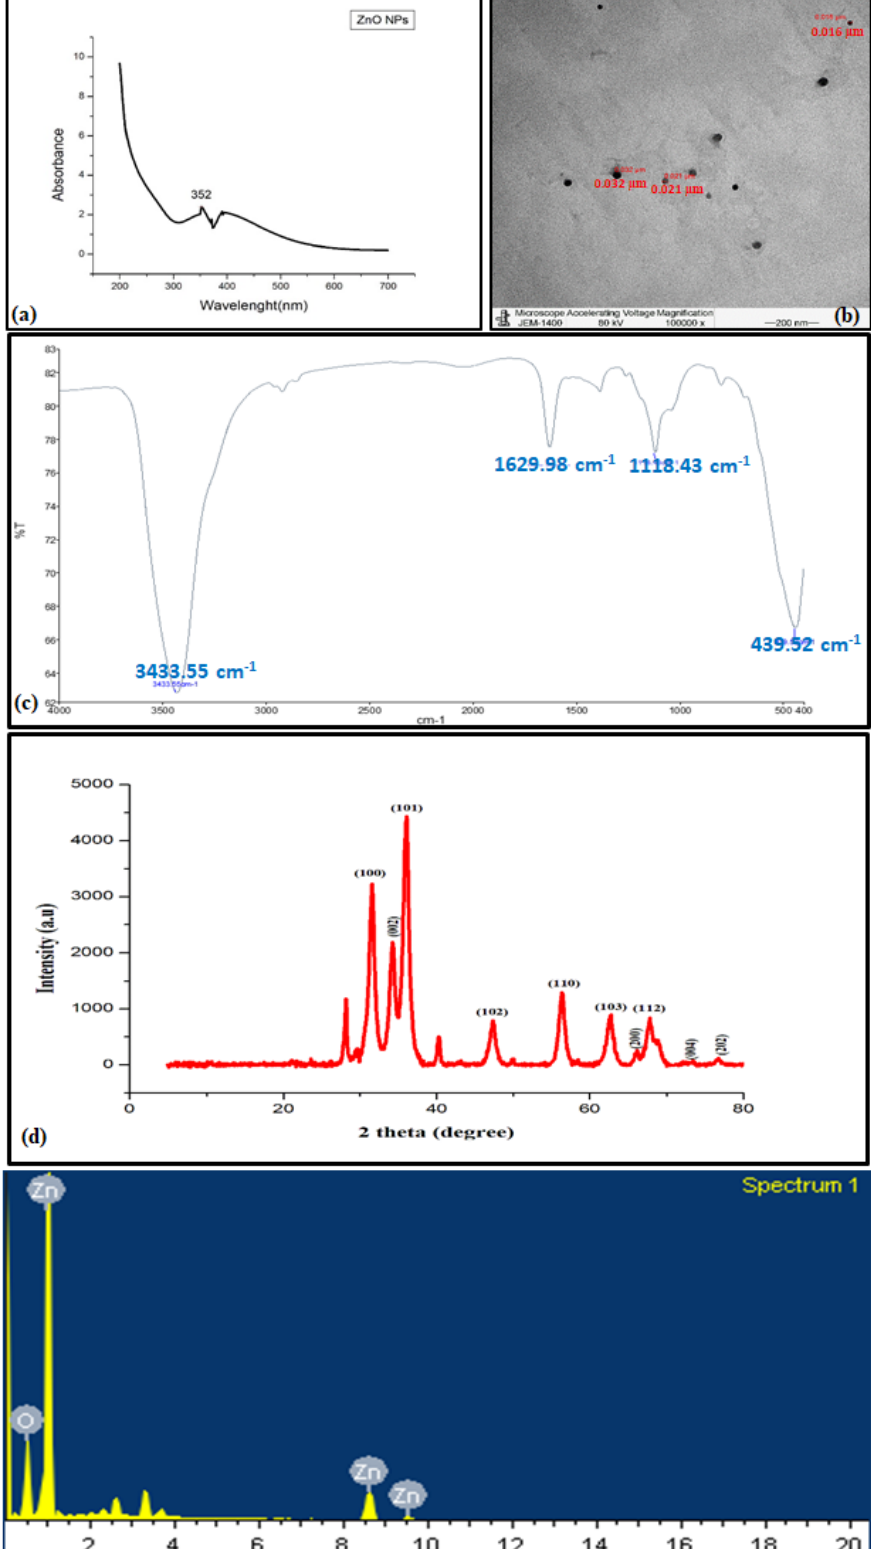
Figure 2. UV − Vis absorption spectra of synthesized ZnO NPs ( a ), ZnO NPs image under transmission electron microscope (TEM) ( b ), FTIR spectrum ( c ), X-ray diffraction (XRD) pattern ( d ), and EDX spectrum ( e ) of the synthesized ZnO